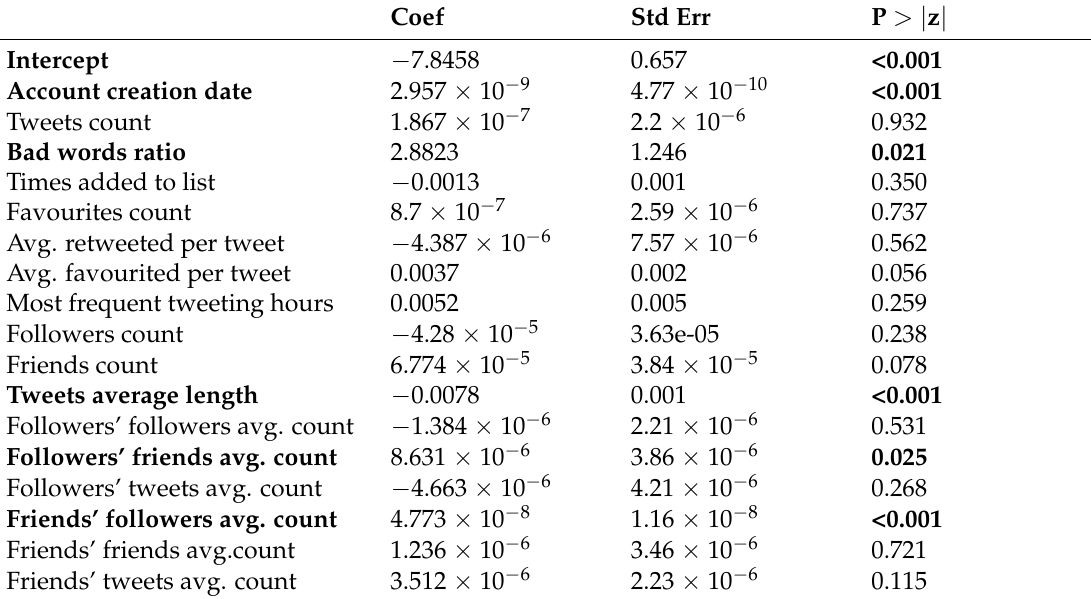
Table 3. GLM regression summary. Predictors statistically significant at the 5% level are shown in bold.